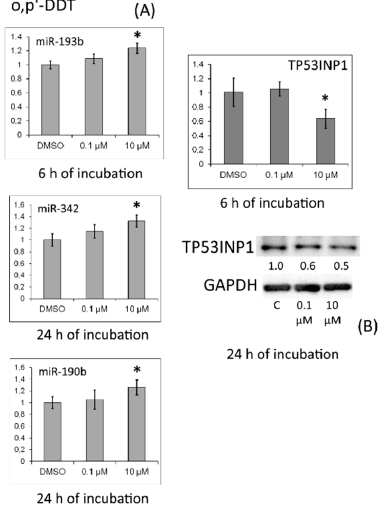
Figure 6. ( A ) Relative levels of TP53INP1 mRNA and of miRNAs targeting it (miR-193b and miR-342) in MCF-7 cells exposed to o,p ′ -DDT. The Y-axis shows the ratio of the mRNA or miRNA amount in the cells treated with a DDT isomer to the mRNA or miRNA amount in the cells treated with DMSO. Each value is the mean of three independent experiments. * Significant differences from the control ( p < 0.05). ( B ) Western blot analysis of TP53INP1 in cells incubated with o,p ′ -DDT. The numbers under TP53INP1 bands denote fold change in the protein level as compared to the first band (control); each data point was normalized to the corresponding GAPDH band. We present findings from one of three independent experiments (which yielded similar results).